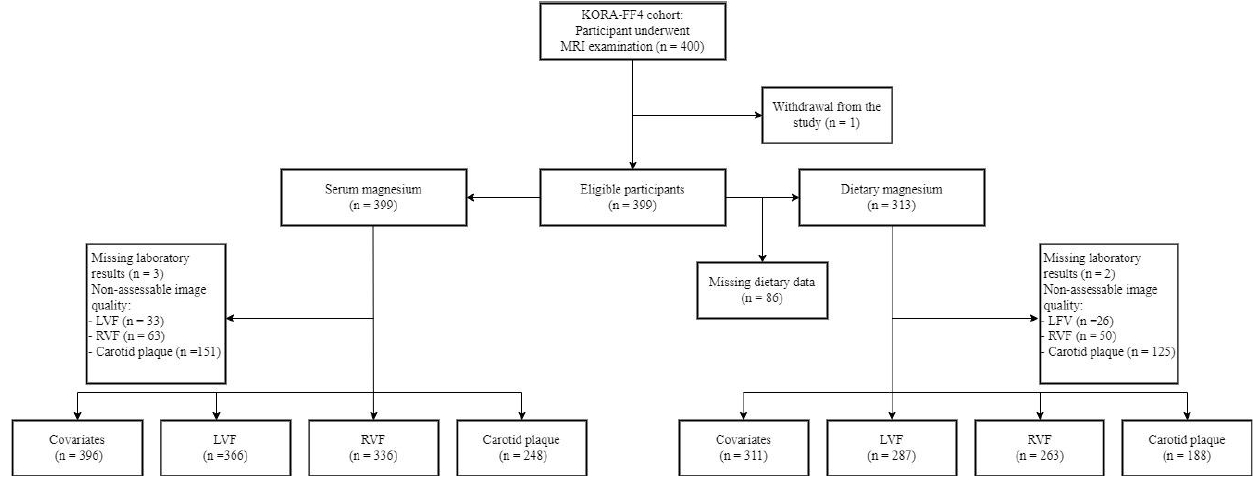
Figure 1. Participant flow diagram. LVF, left ventricular function; RVF, right ventricular function.